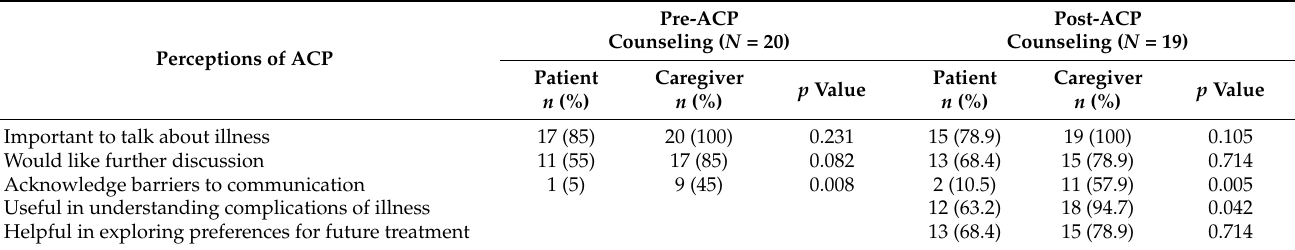
Table 2. Patient–caregiver dyads’ perceptions of